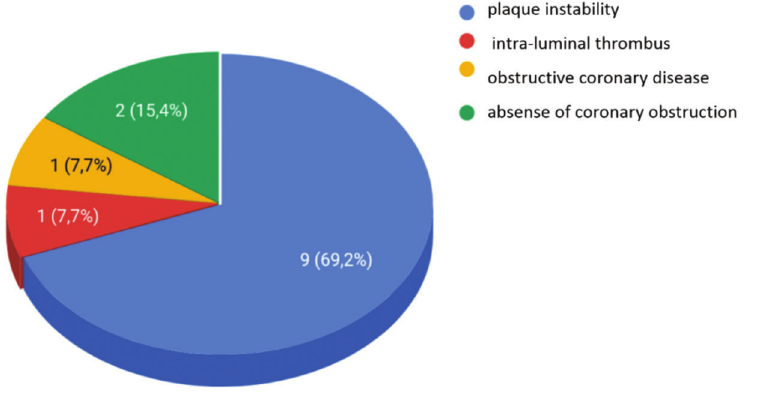
Figure 3 - Obstructive patterns found in patients with coronavirus disease and acute myocardial infarction submitted to invasive